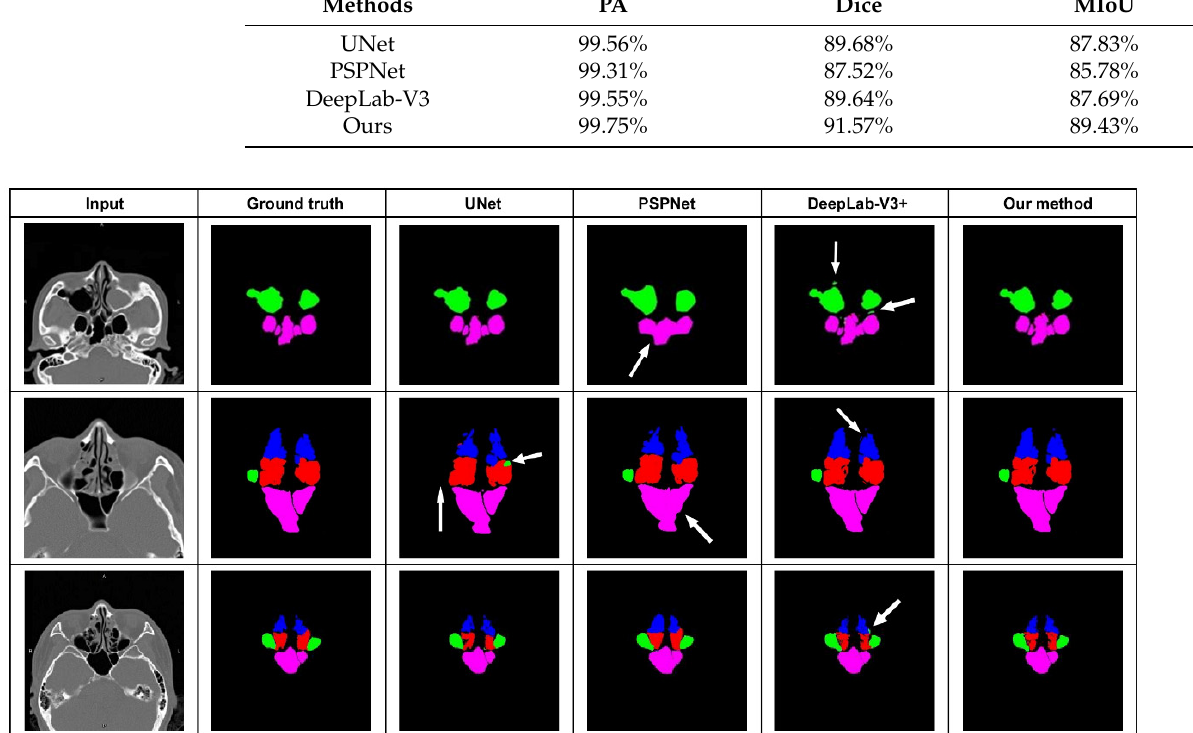
Table 2. Segmentation accuracy of sinus between three observers and automatic segmentation methods. Table 1. Analysis agreement for our automatic segmentation result among three observers.